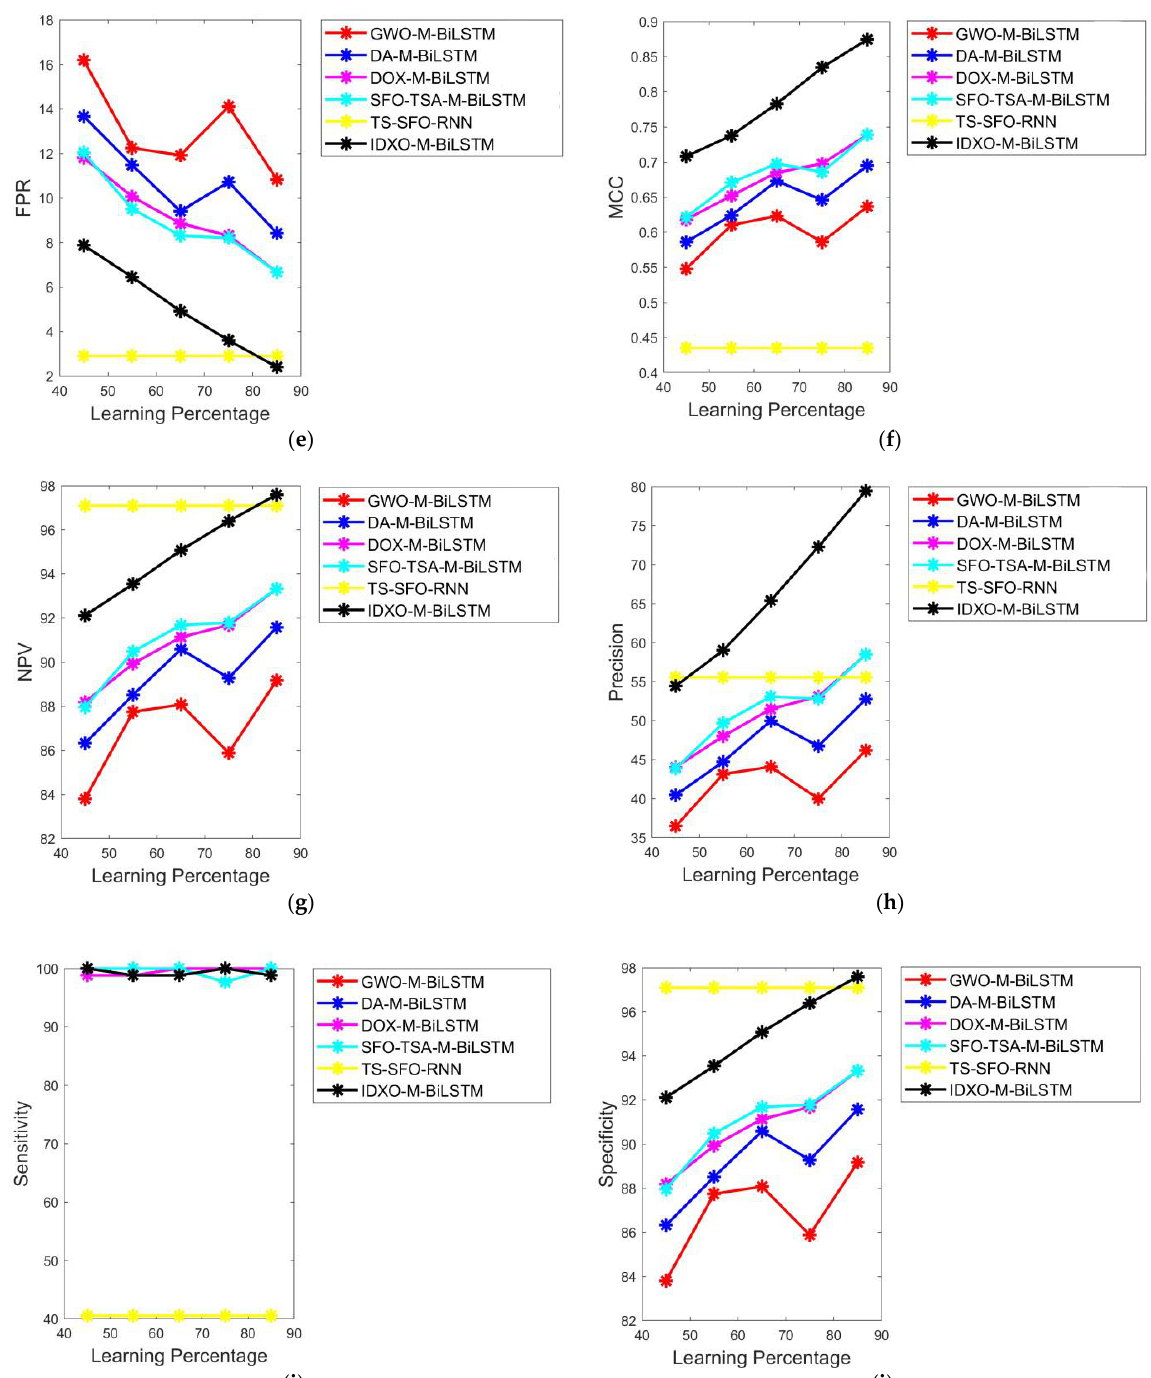
Figure 6. K-fold analysis of the suggested heart disease prediction model with conventional approaches (GWO-M-BiLSTM [44], DA-M-BiLSTM [45], DOX-M-BiLSTM [46], SFO-TSA-M-BiLSTM [47], TS-SFO-RNN [48]) over ( a ) accuracy, ( b ) F1-score, ( c ) FDR, ( d ) FNR, ( e ) FPR, ( f ) MCC, ( g ) NPV, ( h ) precision, ( i ) sensitivity and ( j ) specificity Overall simulation analysis of the suggested model with existing prediction algorithms.